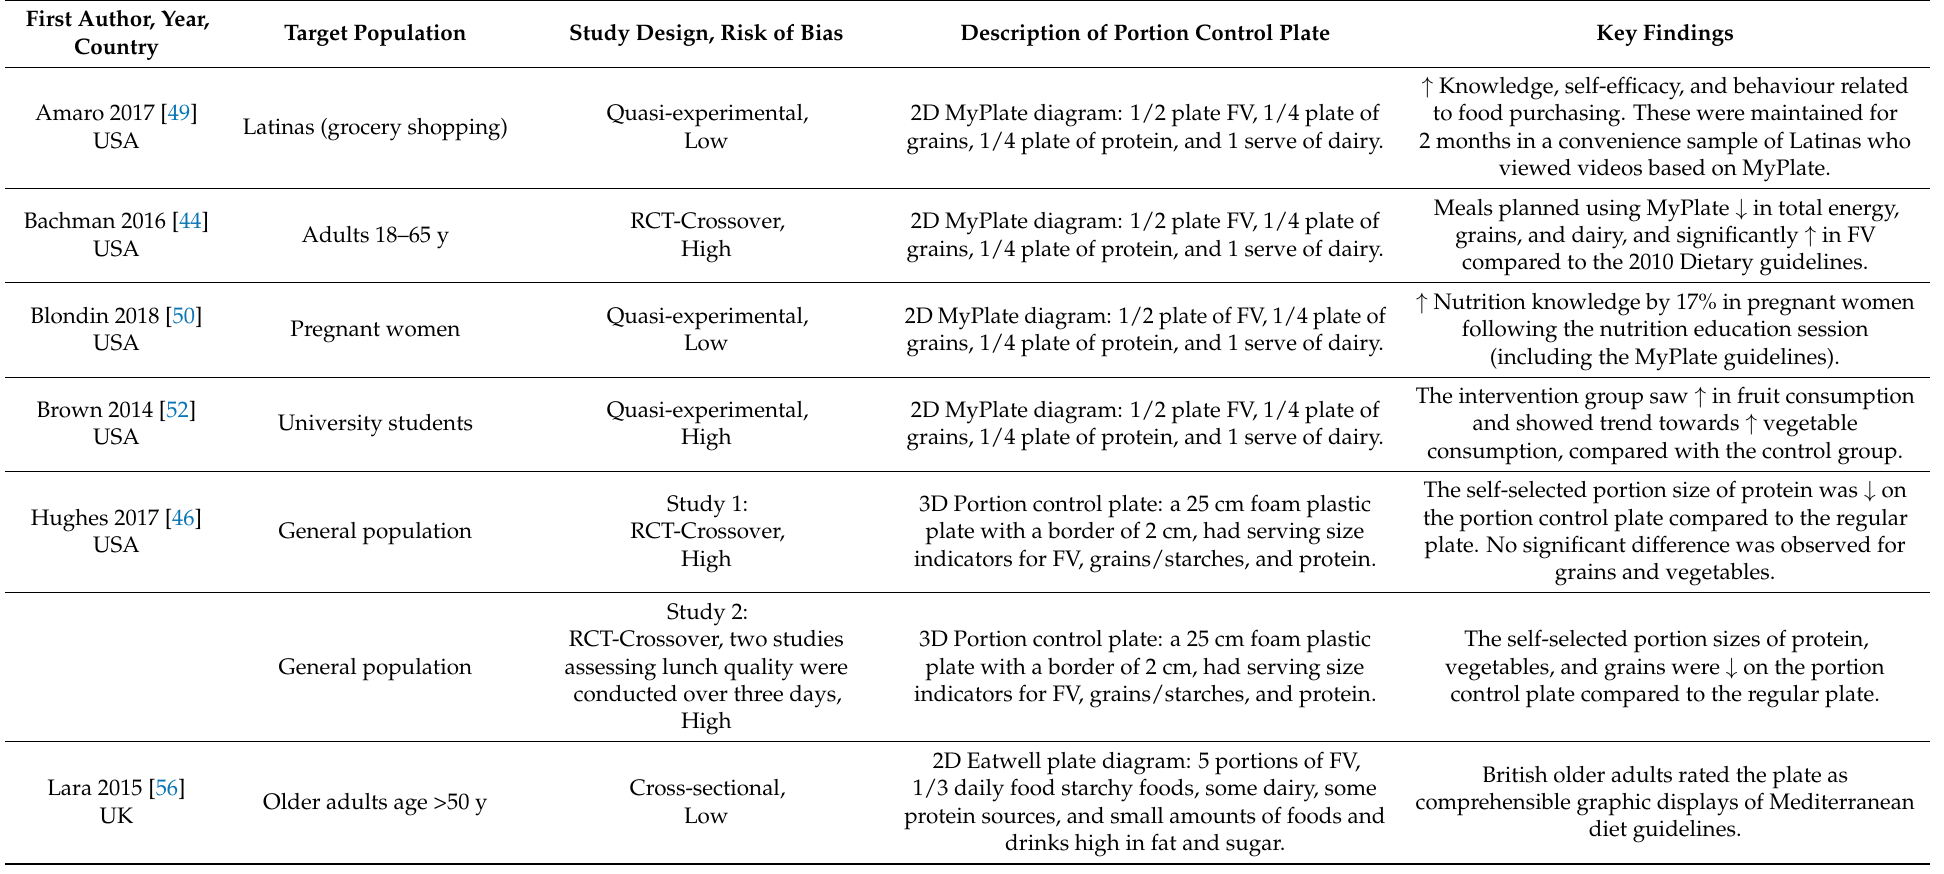
Table 1. Studies reporting changes in nutrition knowledge and dietary behaviours in